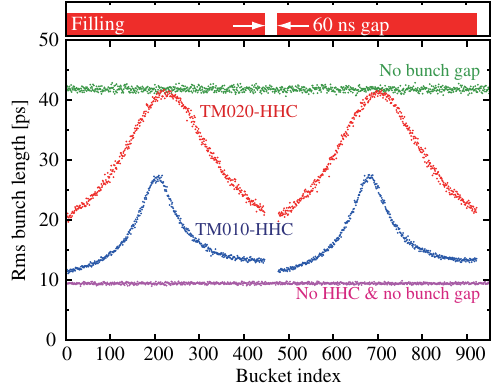
Table III. In case (iv), we assumed the third-harmonic